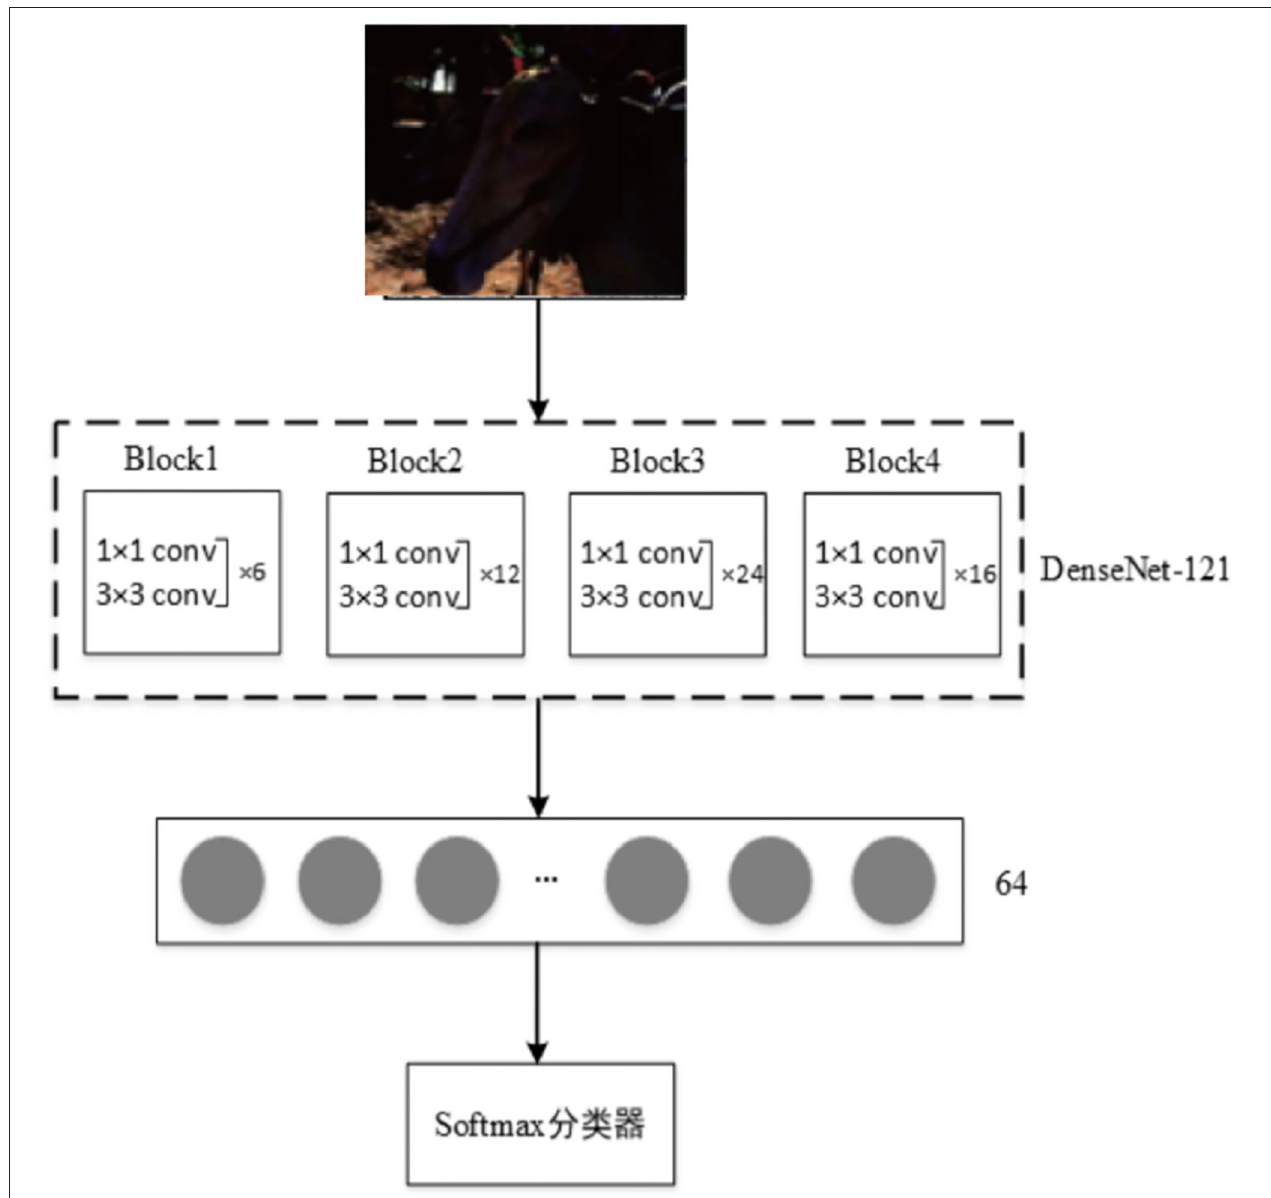
FIGURE 3 | Modified DensNet